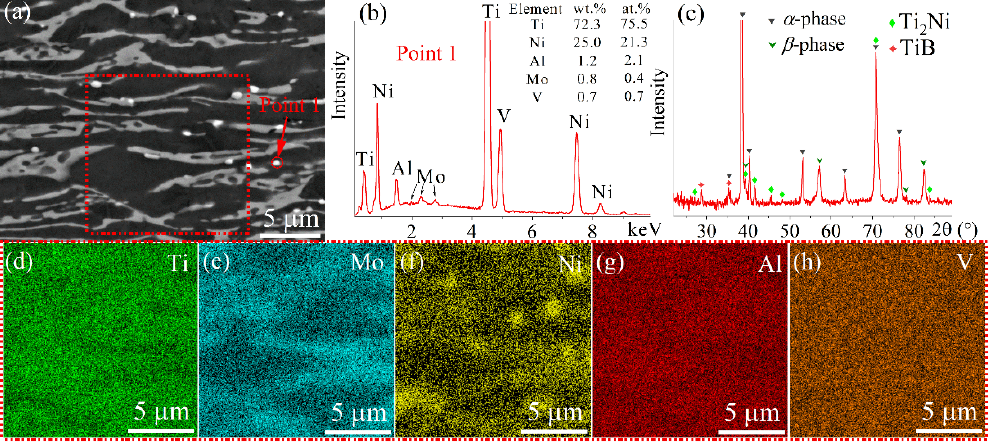
Figure 3. ( a ) SEM image, ( b ) EDS spectra for point 1 in ( a , c ) the XRD pattern, and ( d – h ) EDS-SEM maps of sheets of 2Ni alloy hot-rolled at 700 °C for the area marked with a dotted red frame in ( a ). Grain sizes and volume fractions of the α and β phases were measured after anneal-